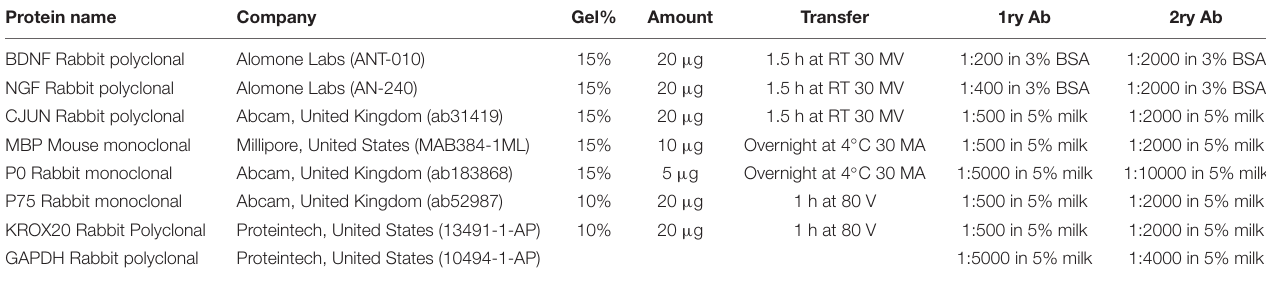
TABLE 2 | Antibodies and experimental conditions used for Western Blot